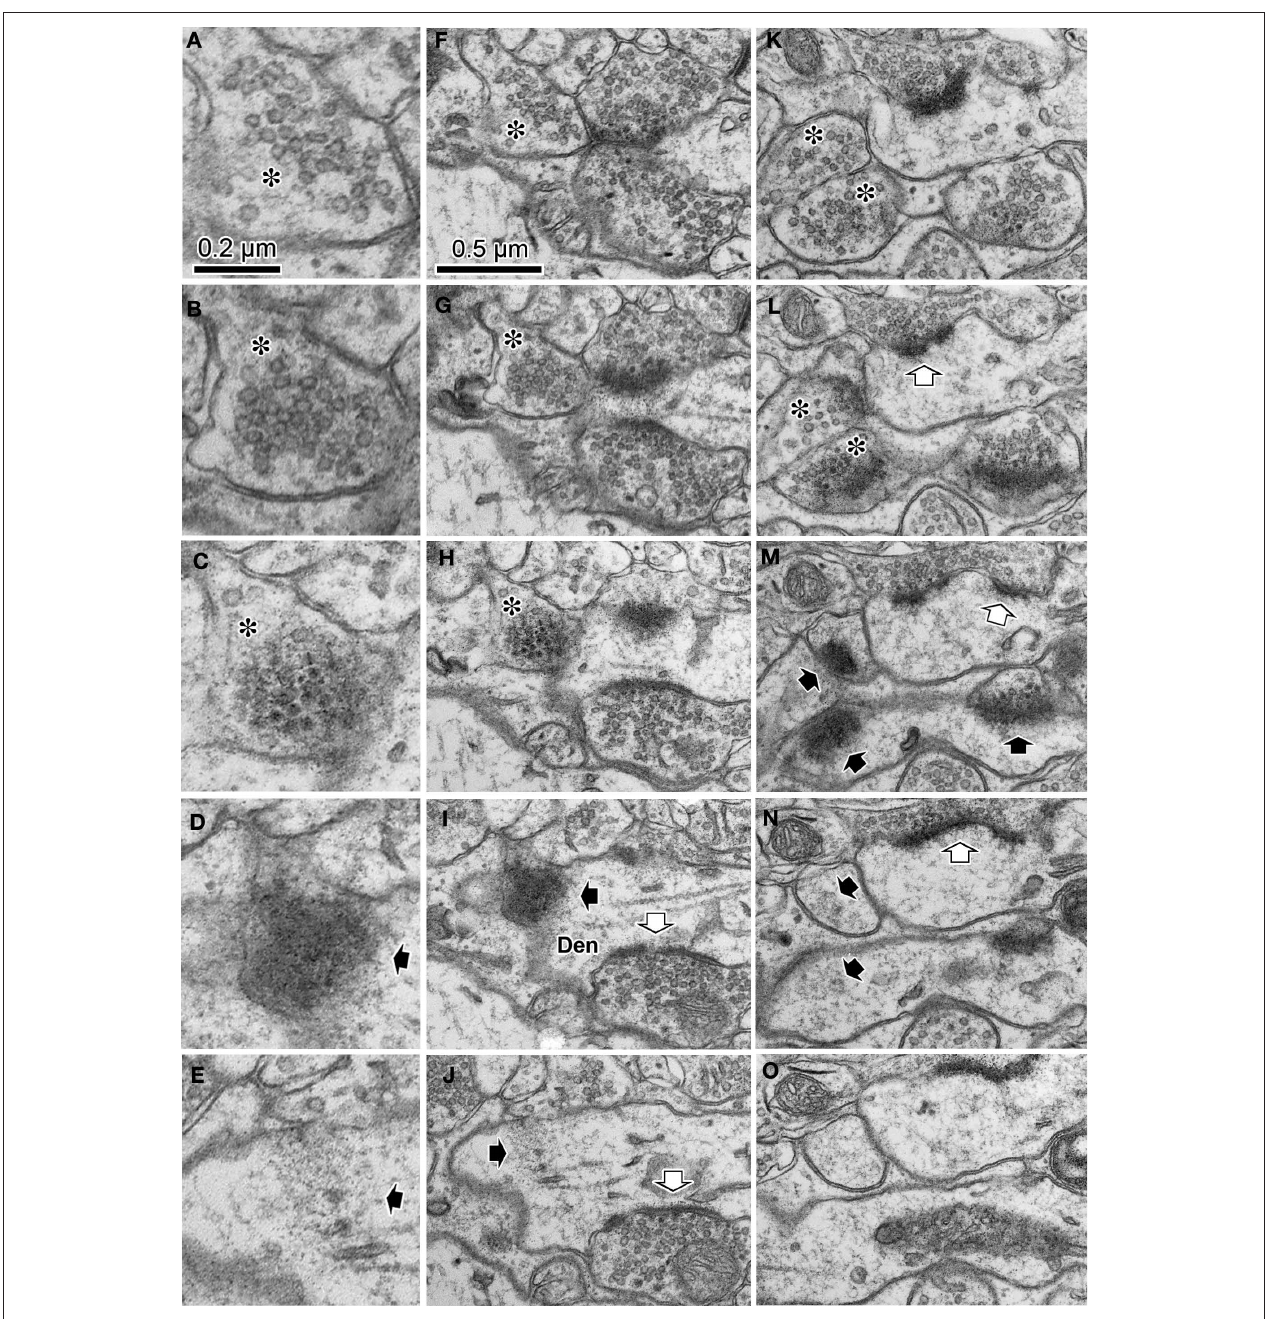
FIGURE 3 | Serial ultrathin sections containing synapses with cleft plane cut in parallel or obliquely. (A–E) A synaptic contact with a cleft plane cut in parallel to the section plane is identifi ed in the successive serial sections. In the fi rst and second sections, many synaptic vesicles are found in the presynaptic bouton ( A, B, asterisk). The next section contains only a few vesicles and many round- shaped electron dense spots of about 35 nm diameter ( C, asterisk), that are likely to correspond to the pre-synaptic grid. The fourth section contains electron dense objects indicative of a PSD ( D, black arrow). In the fi fth section, we observe a small part of the electron dense objects and the cytoplasm of the postsynaptic dendrite ( E, black arrow). Scale bar in (A) is for (A–E) . Wider fi eld of this synaptic structure in serial sections were shown in (F–J) to see the surround